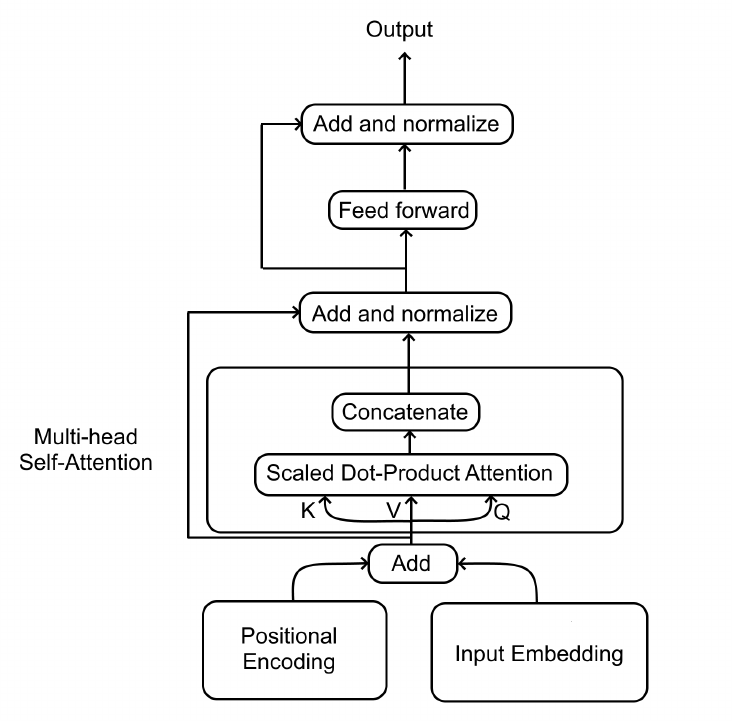
Figure 5. Architecture of the multi-layer